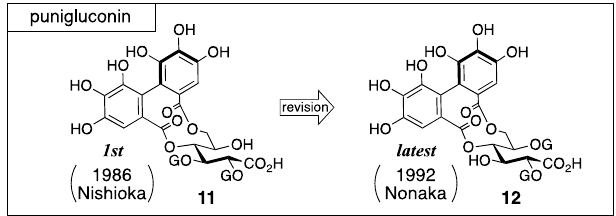
Figure 6. The transition of the structure of punigluconin.